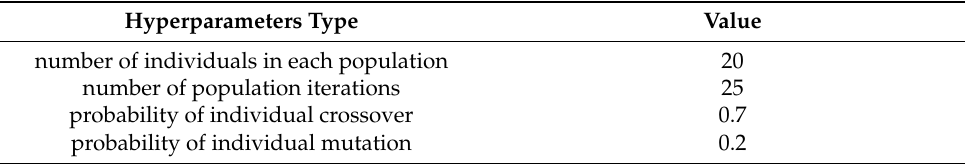
Table 5. NSGA-II Multiobjective optimization algorithm hyperparameters selection.